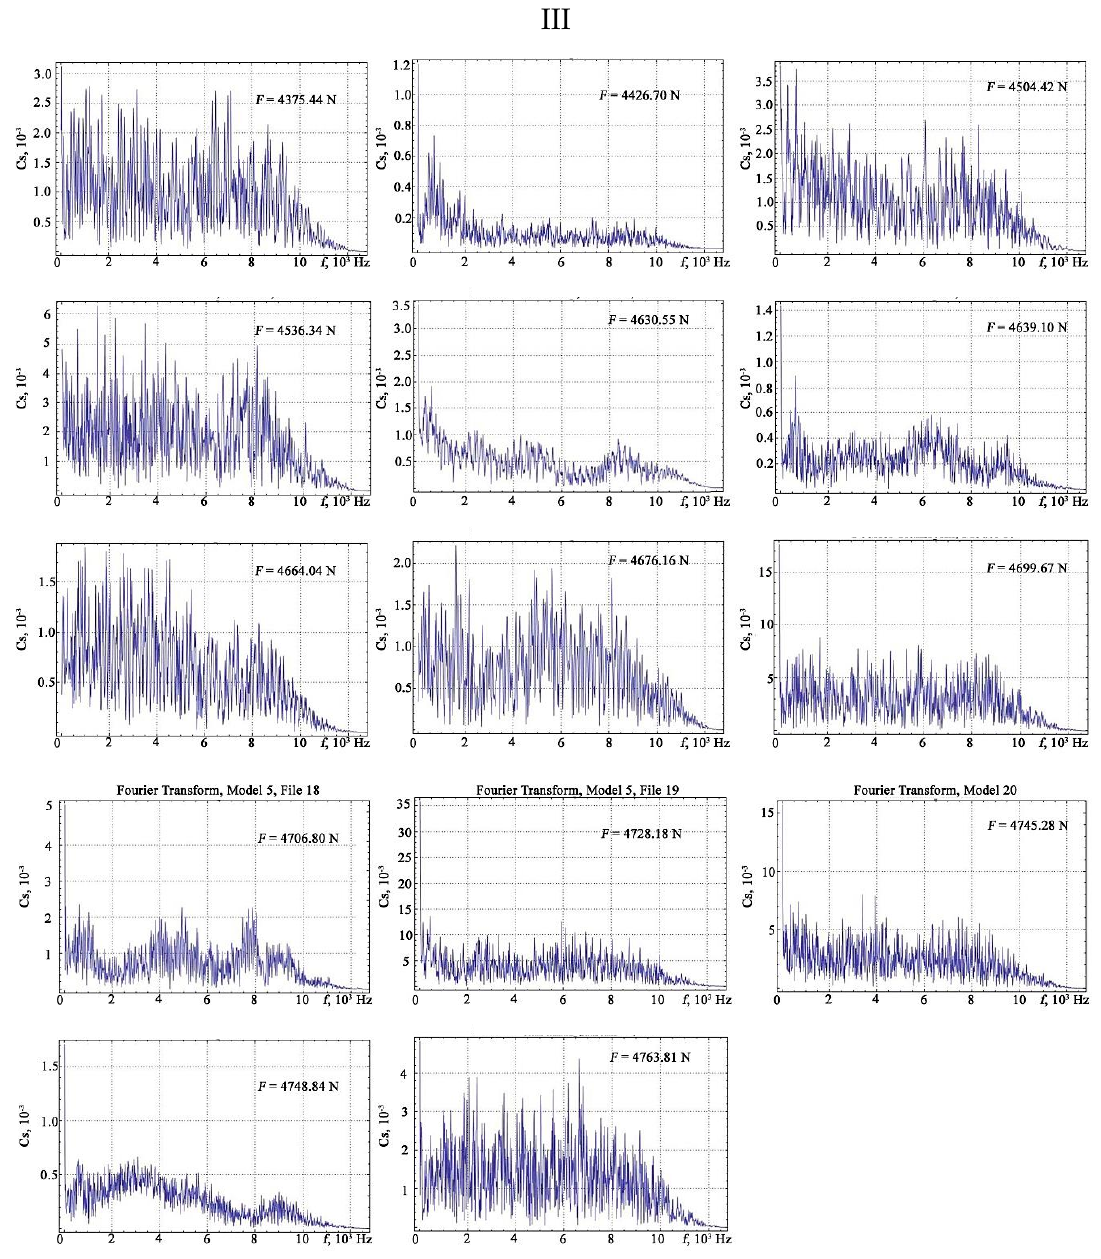
Figure 12. The results of the discrete Fourier transform of the vibration signals under different loads: III—phase of hardening.